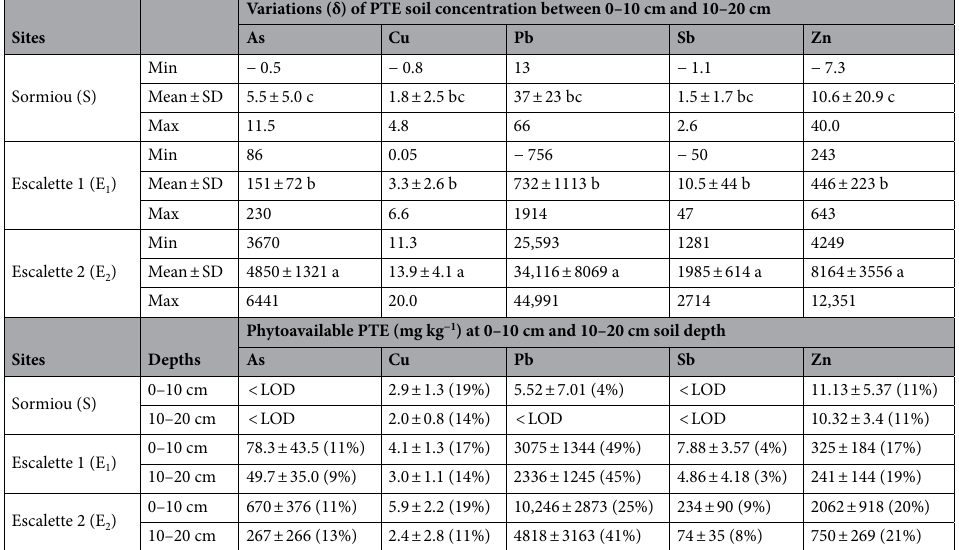
Table 3. Variations (δ) of PTE (pseudo-total concentrations) between 0–10 cm and 10–20 cm depth within the same sample (δ = [PTE] 0–10 – [PTE] 10–20 ) and soil phytoavailable PTE concentrations (mean ± standard deviation (n = 5)). For phytoavailable PTE, the percentage in brackets refers to the ratio of the phytoavailable PTE concentrations on pseudo-total PTE concentrations ([PTE] phytoavailable /[PTE] pseudo-total ). “ < LOD” indicates values below detection limits. In the same row, values followed by different letters are significantly different (Wilcoxon test, P ≤ 0.05).